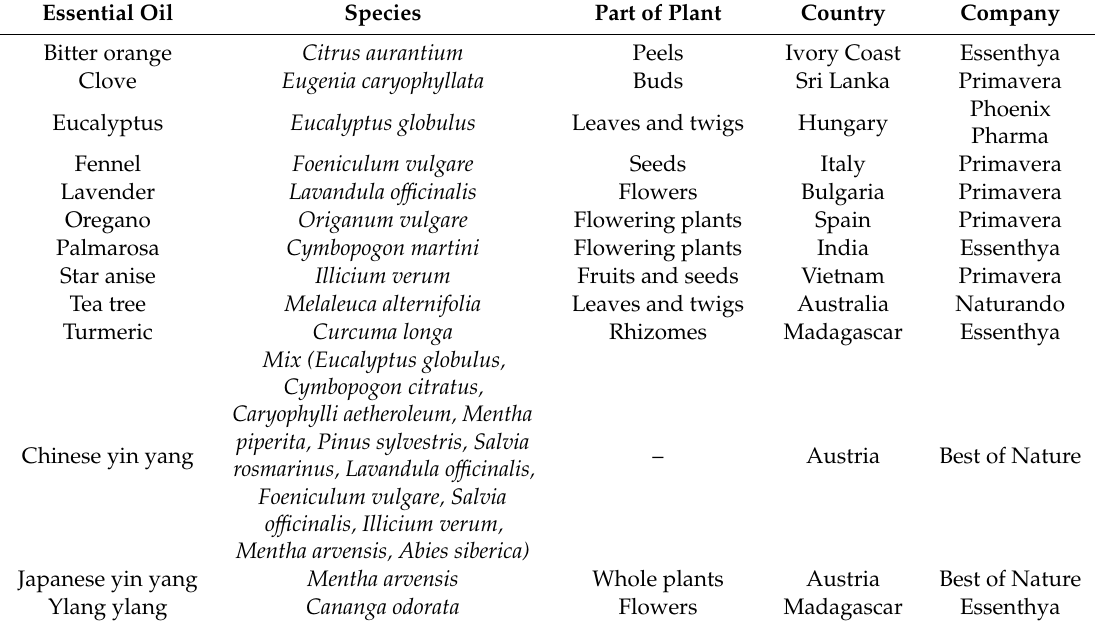
Table 5. Botanical, geographical, and commercial sources of